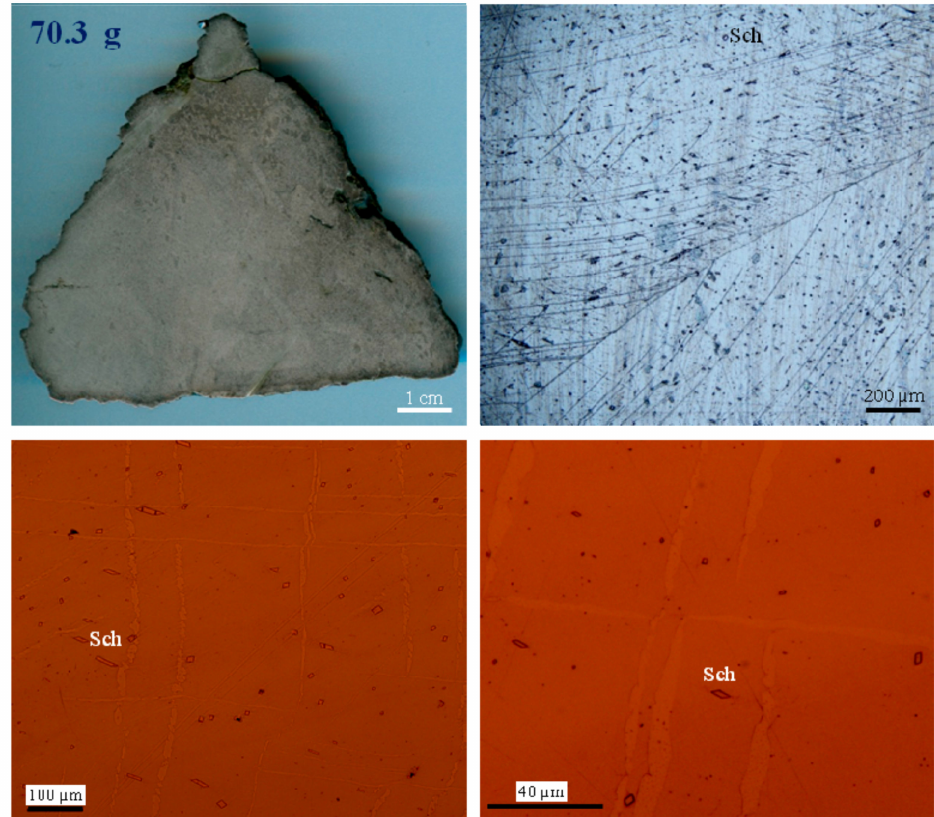
Figure 2. Neumann lines and oriented schreibersite grains (Sch) in Fe-Ni-metal (kamacite), Uakit meteorite (IIAB), images in ordinary and reflected light. Upper images: samples were etched by nital. The upper left image is for type specimen (70.3 g cut-o ff ) of the Uakit meteorite from the CSGM IGM, SB RAS,